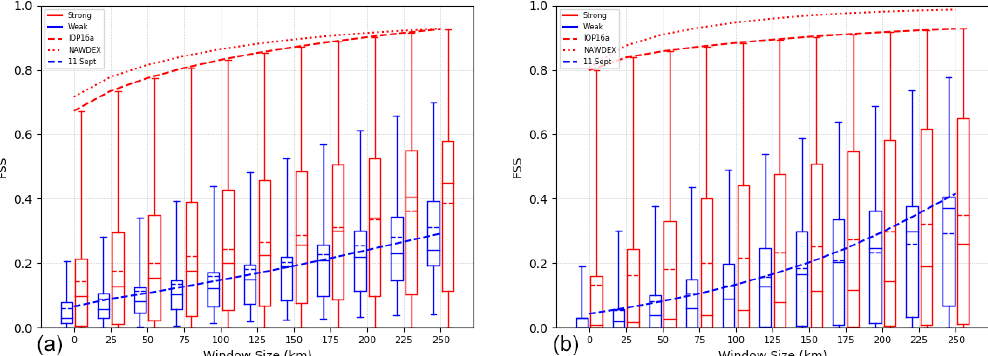
Figure 13. Fraction skill score (FSS) of ensemble mean 3-hourly precipitation vs. interpolated rain-gauge observations as a function of neighbourhood size conditional on weather regime: (a) 0.3mm (3h) − 1 and (b) 10mm (24h) − 1 , all averaged for the entire HyMeX-SOP1. The horizontal line (dashed line) within the boxes indicates the median (mean). The boxes and whiskers are slightly displaced at the discrete window sizes (weak to the left, strong to the right) to increase readability. Additionally, the FSS of the prominent cases is depicted.